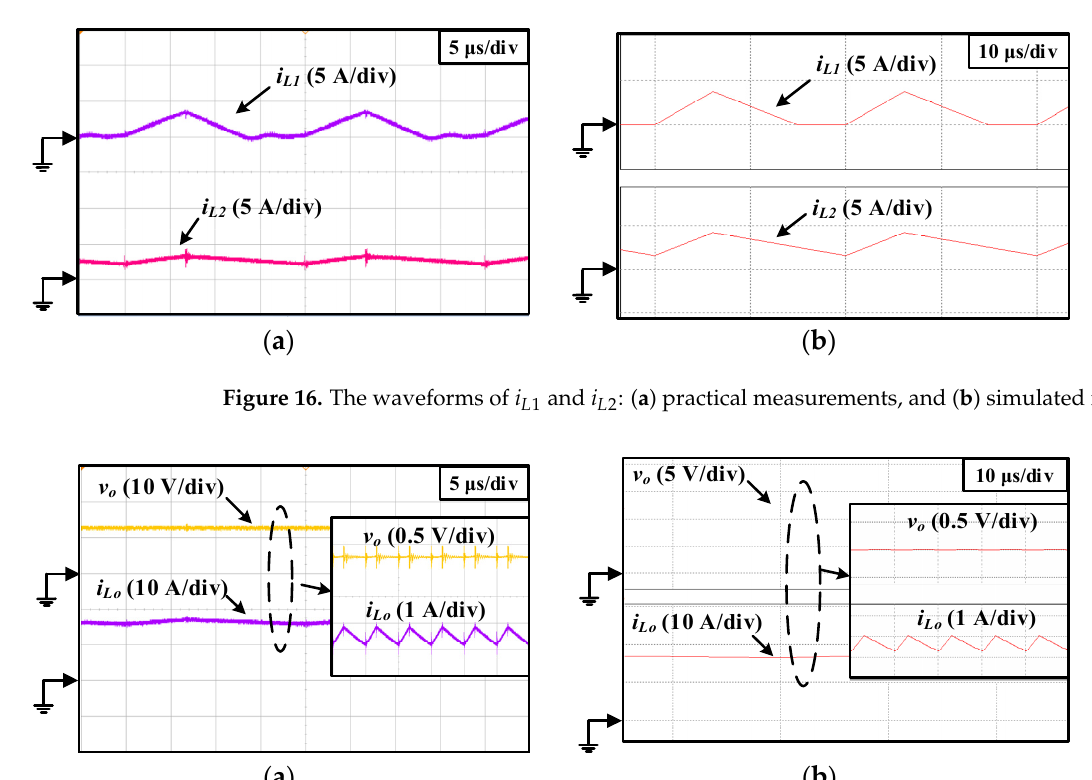
Figure 15. Measured results and simulations of all diodes in the proposed converter: ( a ) practical